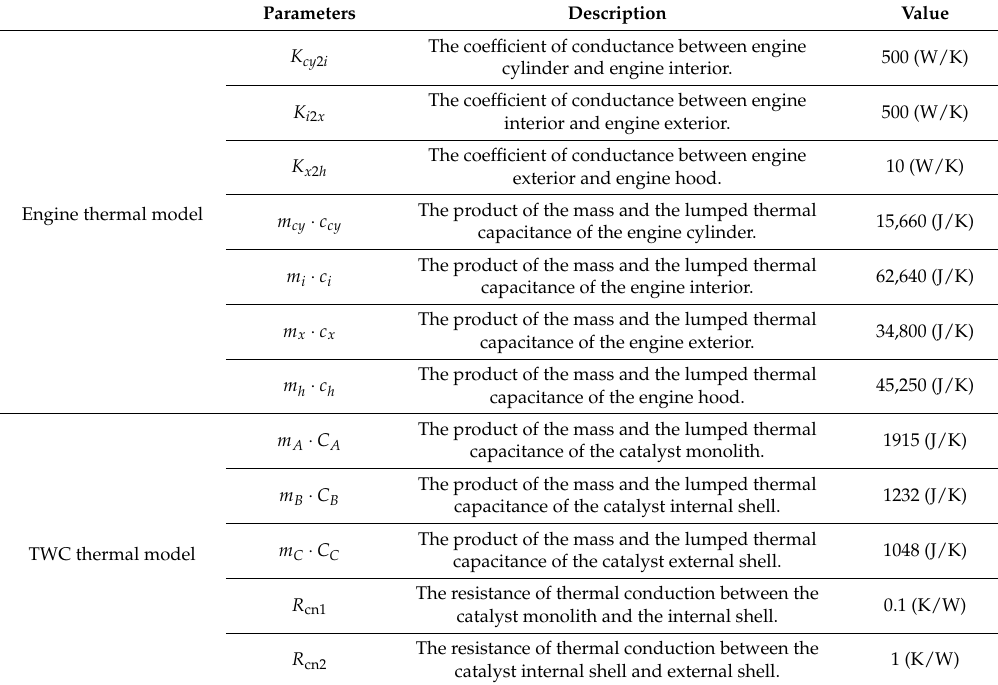
Table 4. Thermal models’ parameters determined from model tuning and